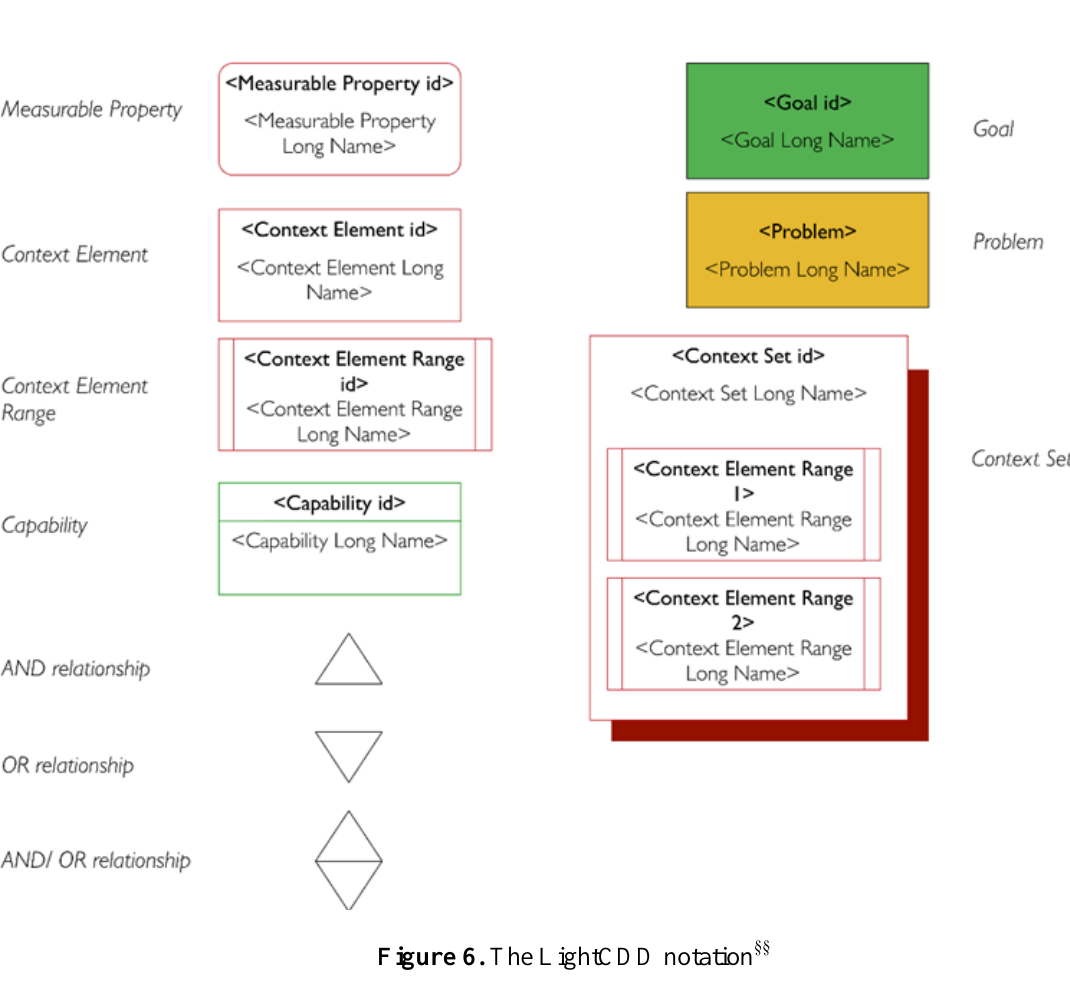
Figure 6. The LightCDD notation